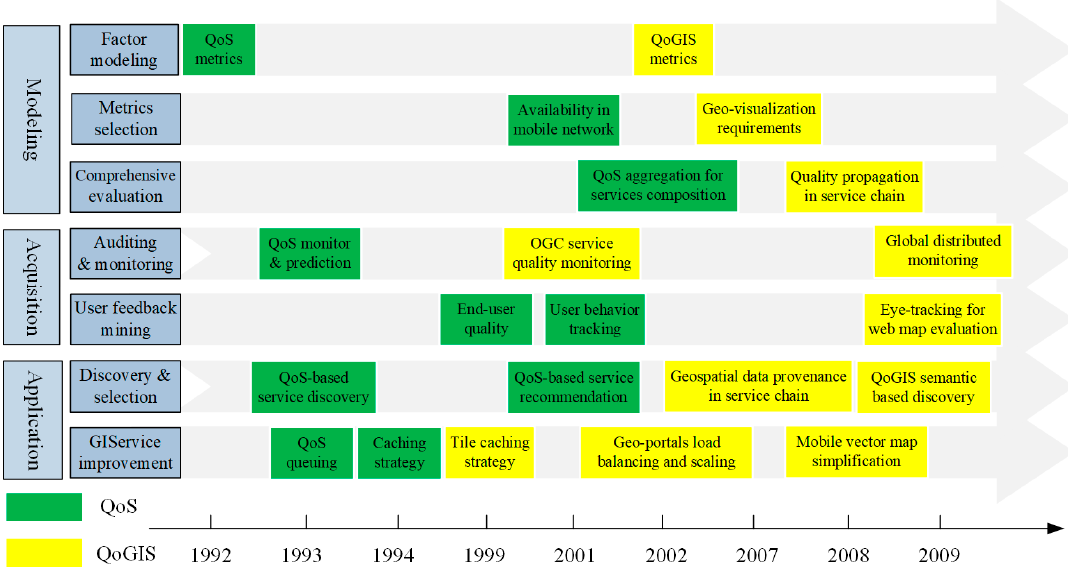
Figure 3. Timeline showing the relationship between QoGIS and QoS topics.